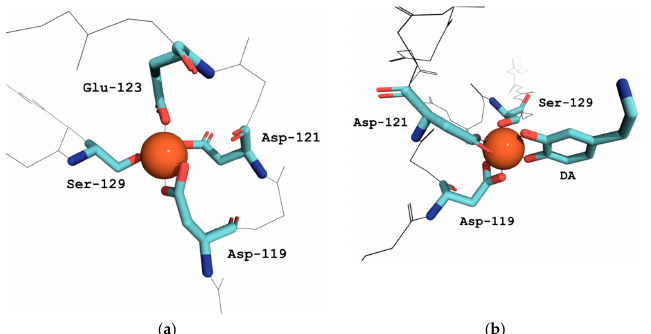
Figure 1. ( a ) Schematic representation of the putative iron coordination sphere of α S [12,13] . ( b ) Schematic representation of one of the possible [Fe(DA)(Ac- α S 119–132 )] ternary complexes, where Fe III is bound to D119, D121, and S129. Both sketches were drawn using the Avogadro and PyMol softwares [17,18] ; the peptide’s backbone was drawn as poly-Gly.